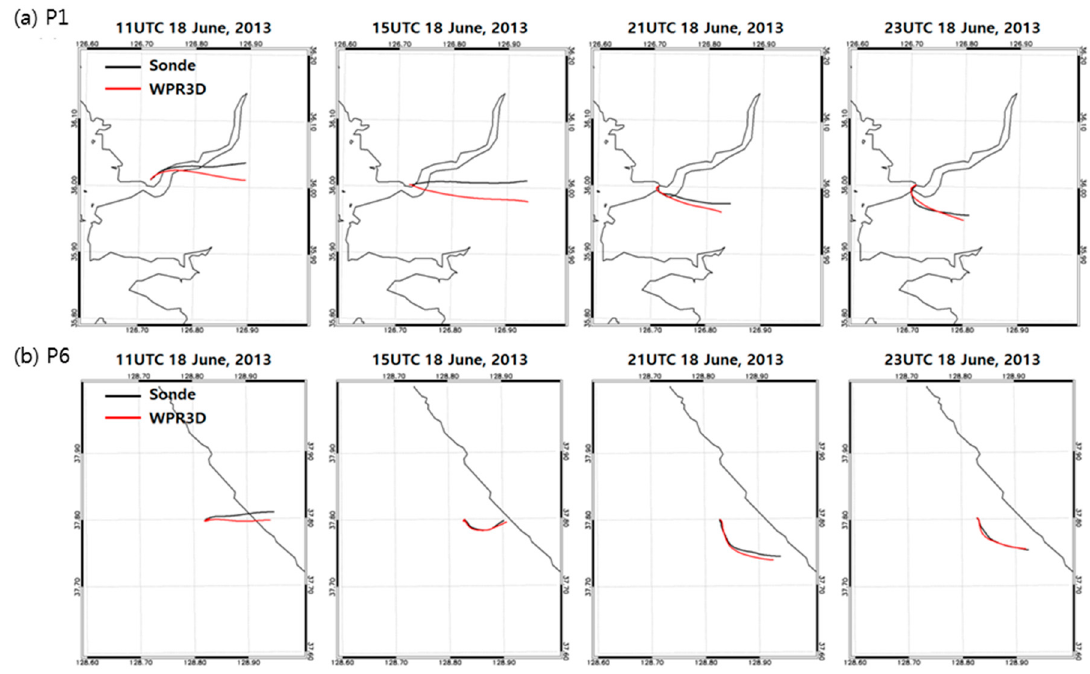
Figure 15. Comparison of the horizontal trajectories from M-WPR3D with those from the GPS radiosonde launched simultaneously ( a ) at P1 and ( b ) at P6 from 11 UTC to 23 UTC on 18 June 2013.